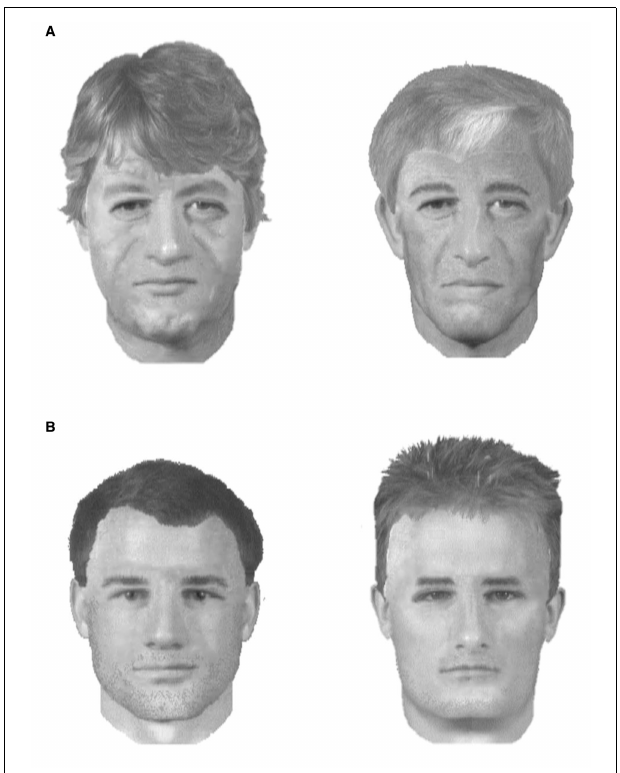
FIGURE 1 | Example composites constructed of the professional footballer manager Arsene Wenger, an older age target (A) and the professional football player John Terry, a younger age target (B). The composites constructed by the younger age group are on the left, and those constructed by the older age group are on the right. Due to reasons of copyright, original pictures cannot be shown here.